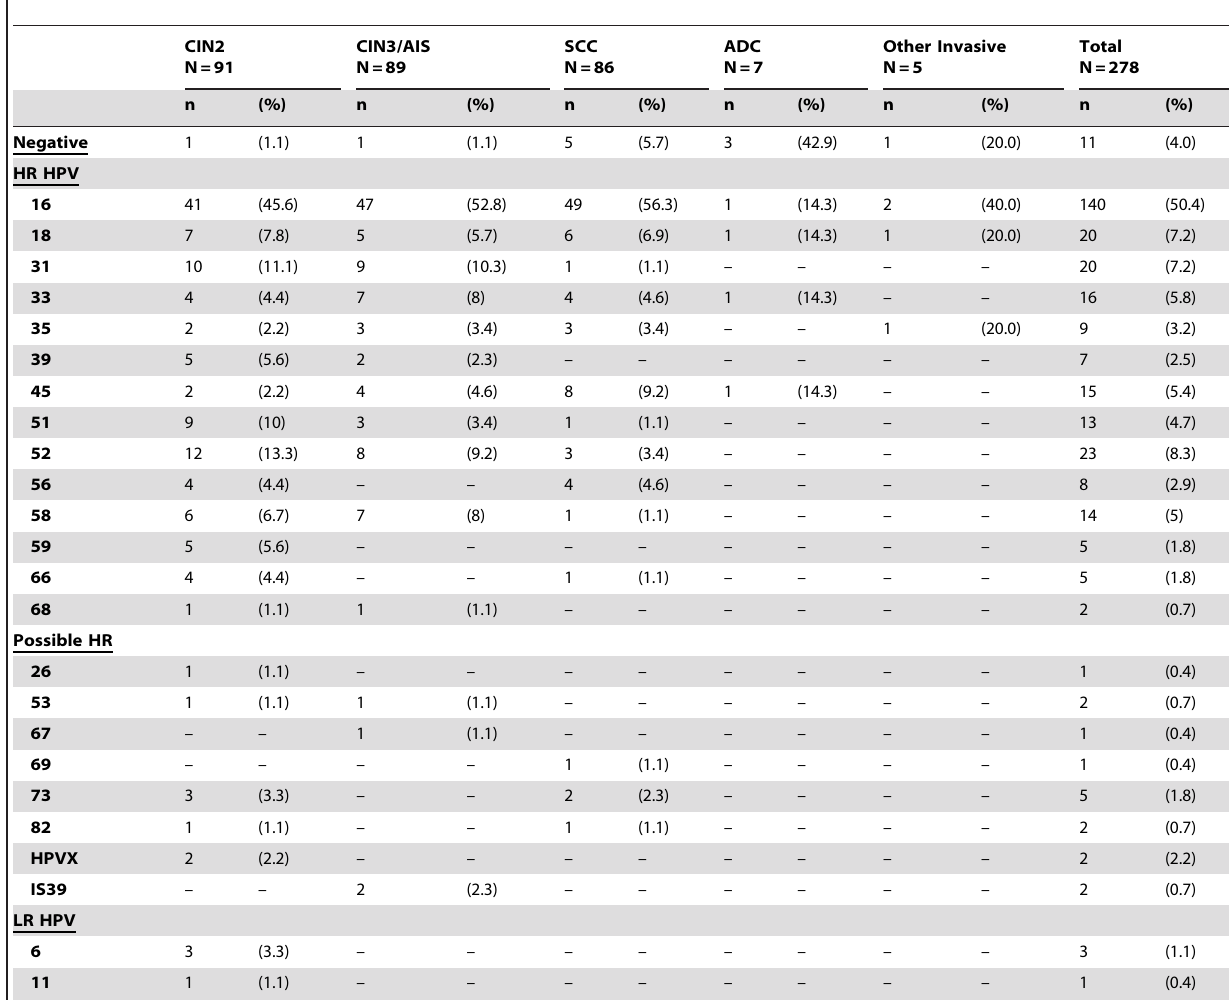
Table 3. HPV type prevalence among females diagnosed with CIN2 + , North Carolina,